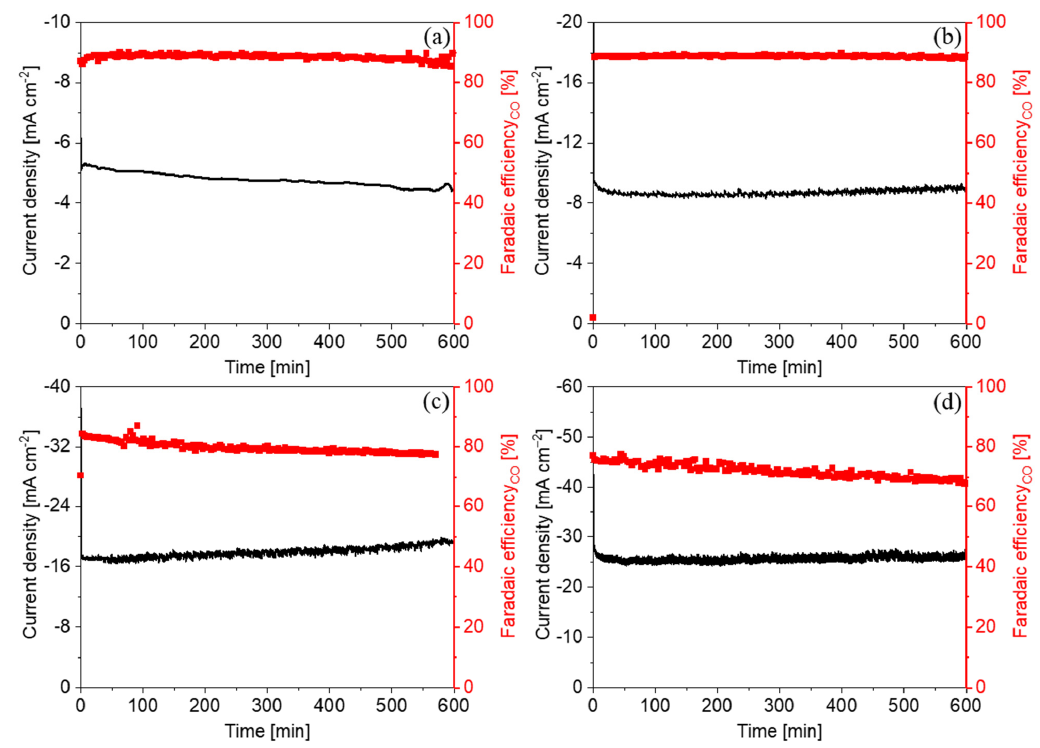
Figure 6. Geometric current density and CO selectivity at a Sn-Cu 2 O electrode during 10-h tests in various CO 2 -saturated KHCO 3 electrolytes: ( a ) 0.1 M, ( b ) 0.5 M, ( c ) 1.0 M and ( d ) 2.0 M.